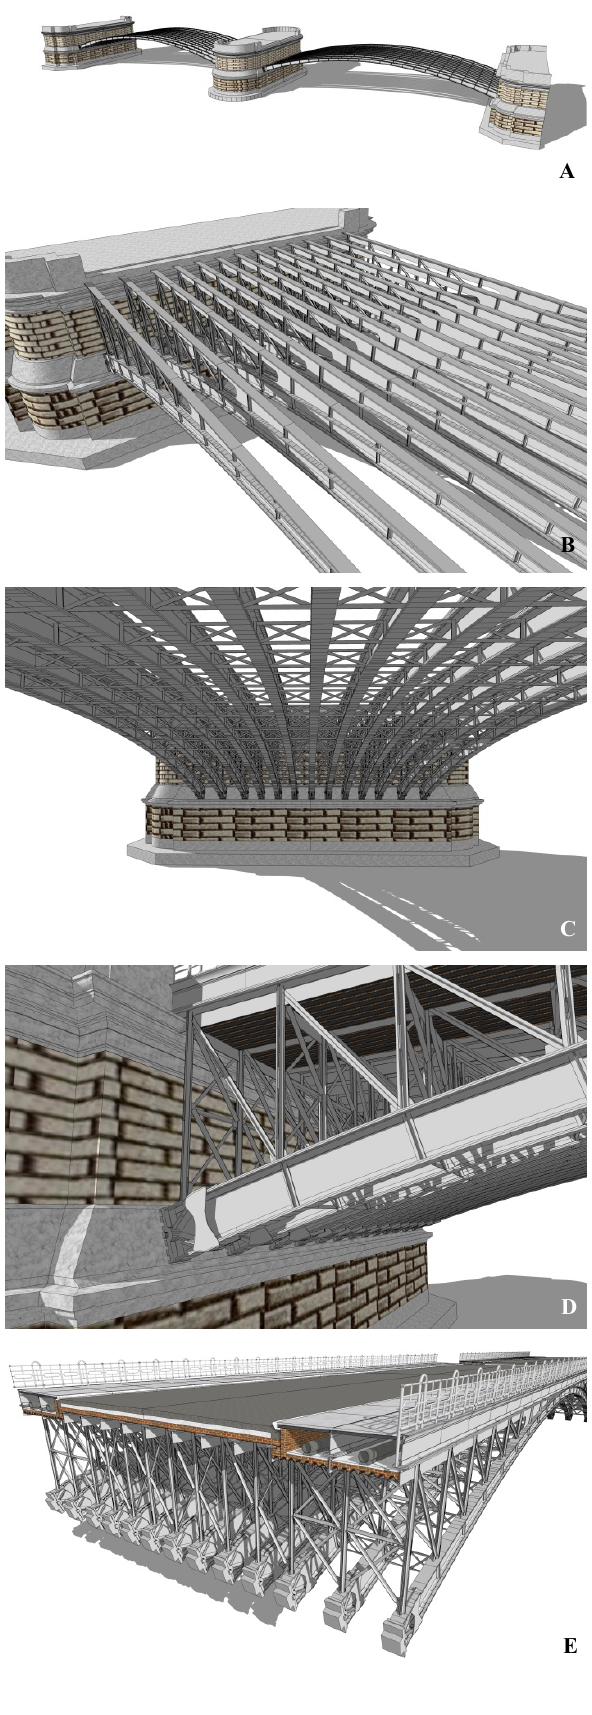
Figure 11. Steps and details of the